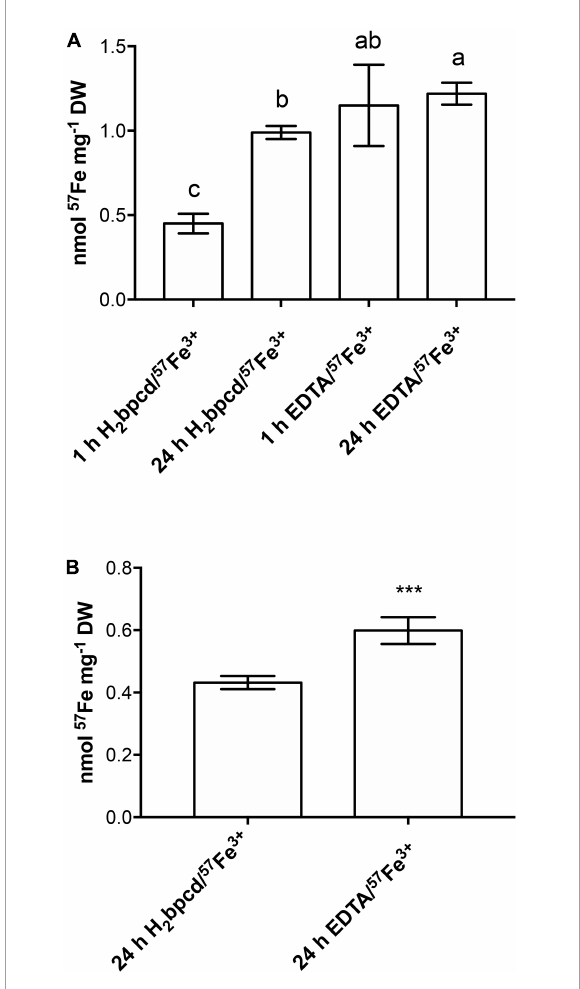
FIGURE8 57 Fe uptake in (A) root of cucumber plants after 1 and 24 h of treatment with H 2 bpcd/ 57 Fe 3 + or EDTA/ 57 Fe 3 + and (B) in shoot after 24 h of the same treatments. Data represent mean ± S.D. of three independent replicates with two plants each ( n = 6) (one-way ANOVA with Turkey’s post hoc test, p < 0.05, significant differences are indicated by different letters and Student’s t -test: *** p <